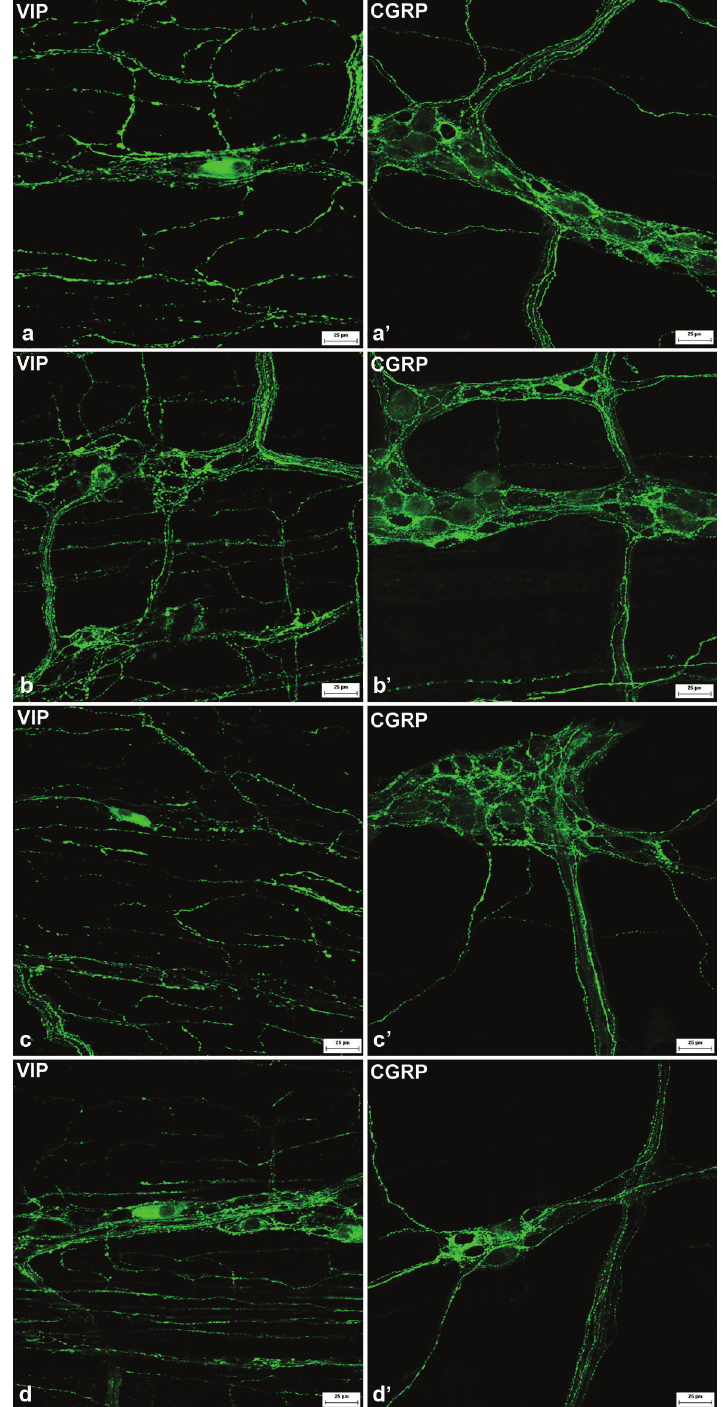
Figure 4 - Confocal photomicrographs of VIP-IR ( a , b , c , d ) and CGRP-IR ( a’ , b’ , c’ , d’ ) myenteric varicosities in normoglycemics (group N) ( a , a’ ), normoglycemics supplemented with L-glutamine (group NG) ( b , b’ ), diabetics (group D) ( c , c’ ), and diabetics supplemented with L-glutamine (group DG) ( d , d’ ). Calibration bar = 25 µm. (See the colors in the online